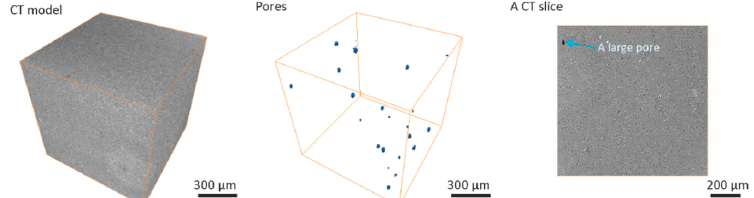
Figure 2. Computed tomography results for Al 2 O 3 greenbody ceramic sample, manufactured with stereolithography-based additive technology, there are shown the original greyscale 3D image acquired with computed tomography (CT), the segmented round pores and a typical CT slice.